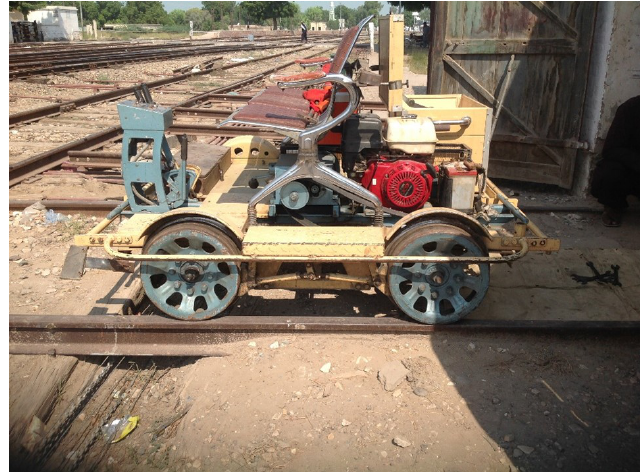
Figure 4. Mechanical railway cart used for data collection. The cart is driven by the engine that is manually controlled.